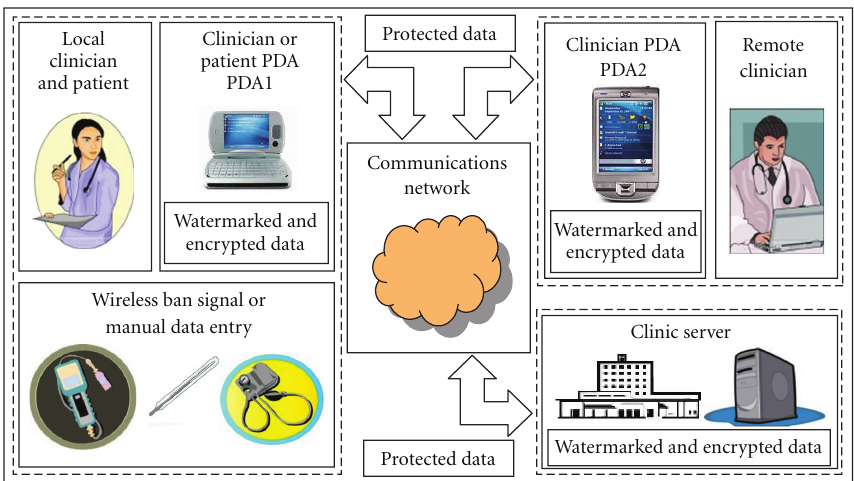
Figure 1: Schematic of the telemedicine system architecture.